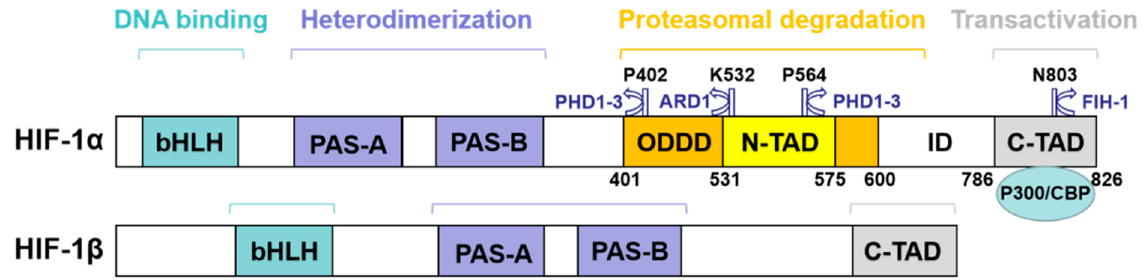
Figure 1. Schematic representation of HIF-1 structure and function.